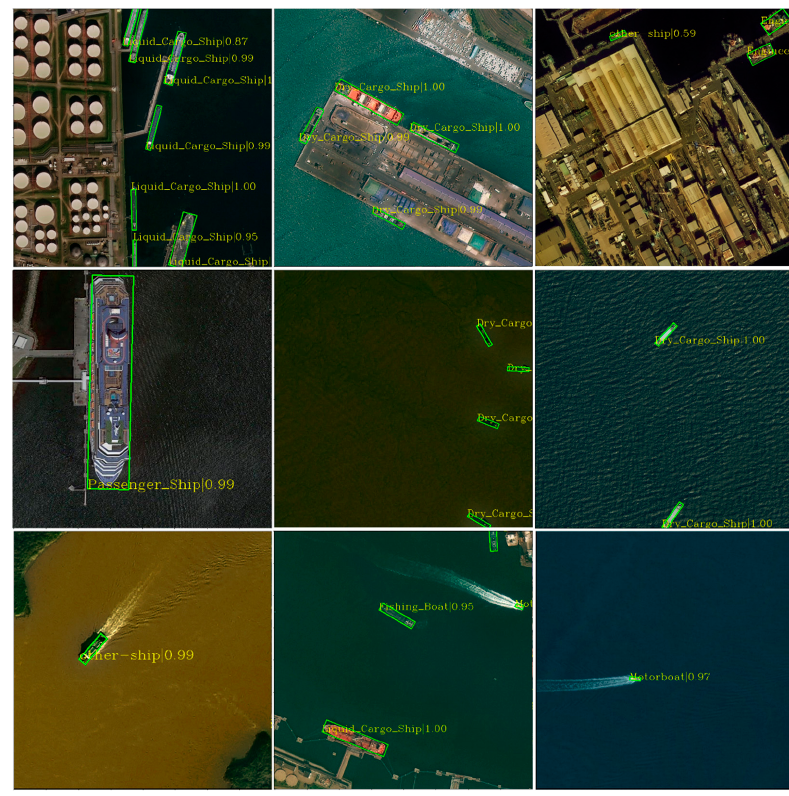
Figure 18. Improved model detection